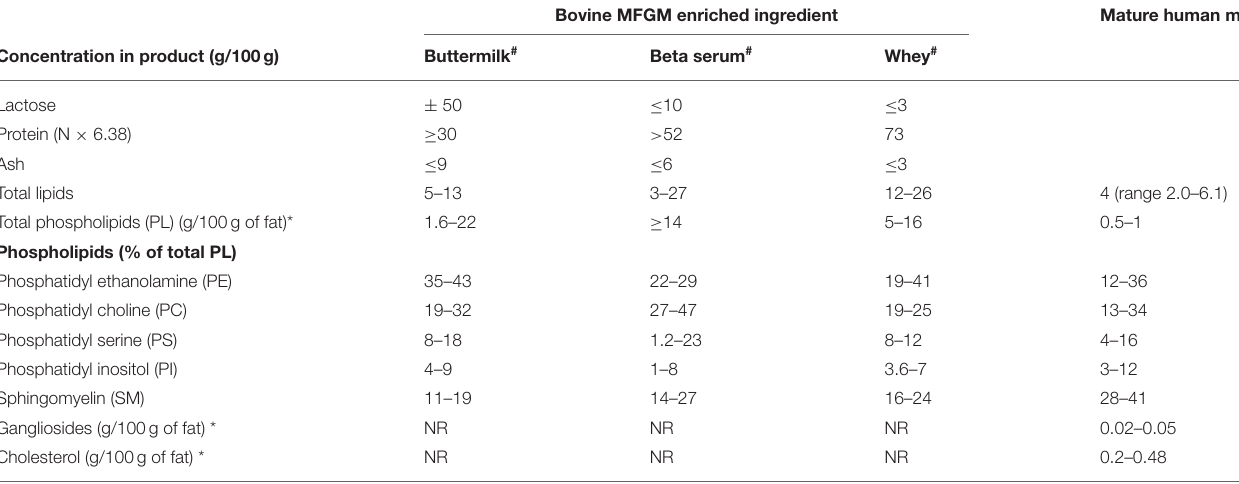
TABLE 5 | The composition of commercially available MFGM-enriched dairy ingredients compared to mature human milk. Bovine MFGM enriched